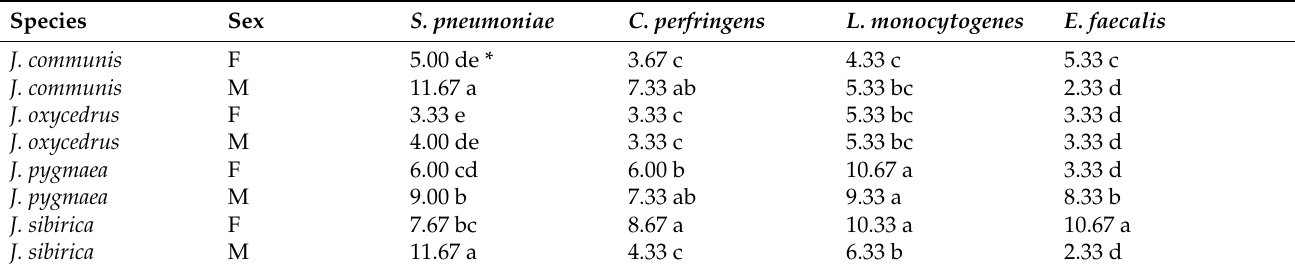
Table 9. Mean antimicrobial activity (inhibition zones in mm) of S. pneumoniae , C. perfringens , L. monocytogenes , and E. faecalis obtained from the eight combinations of species and sex.